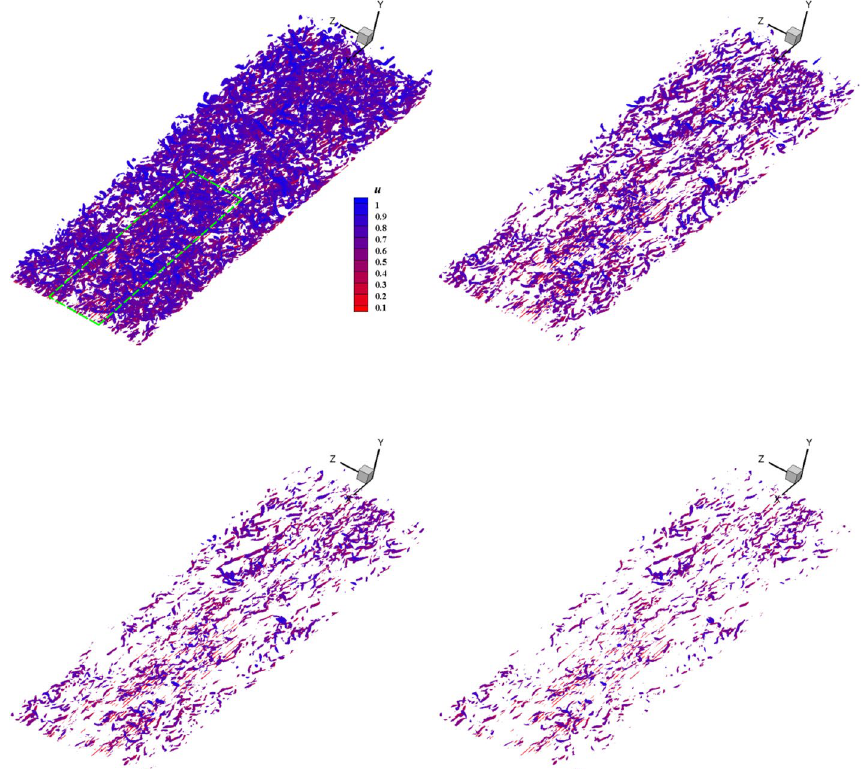
Fig. 26 The second-order invariant of the velocity gradient tensor Q 2 in the riblets case (From top-left to bottom-right: Q 2 20, 50, 80, =